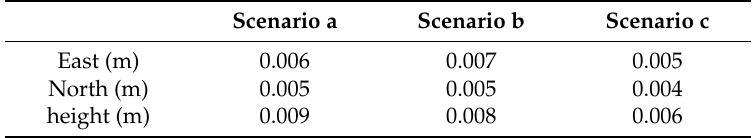
Table 1. RMS of standard deviations of the coordinates of the camera projection